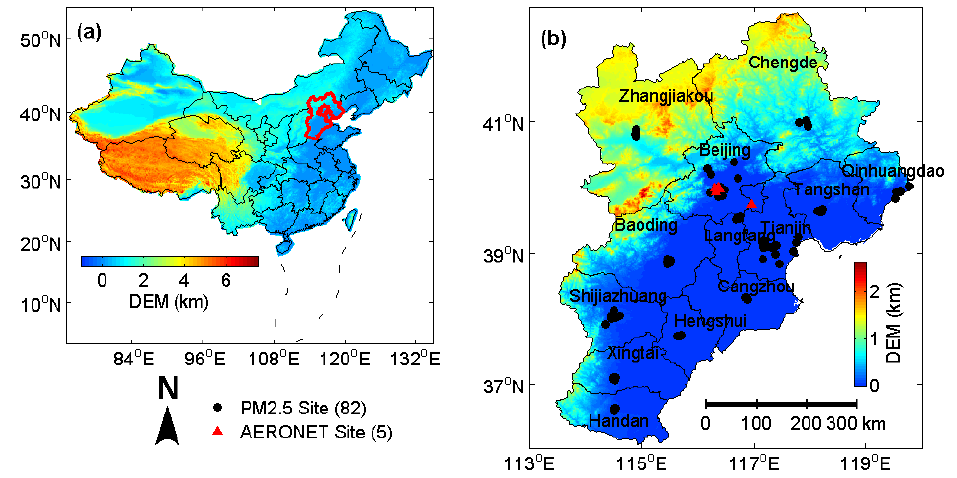
Figure 1. Elevation map of ( a ) China and ( b ) Beijing–Tianjin–Hebei region. (b) Spatial distributions of fine particulate matter (PM) and AERONET sites in Beijing–Tianjin–Hebei region.